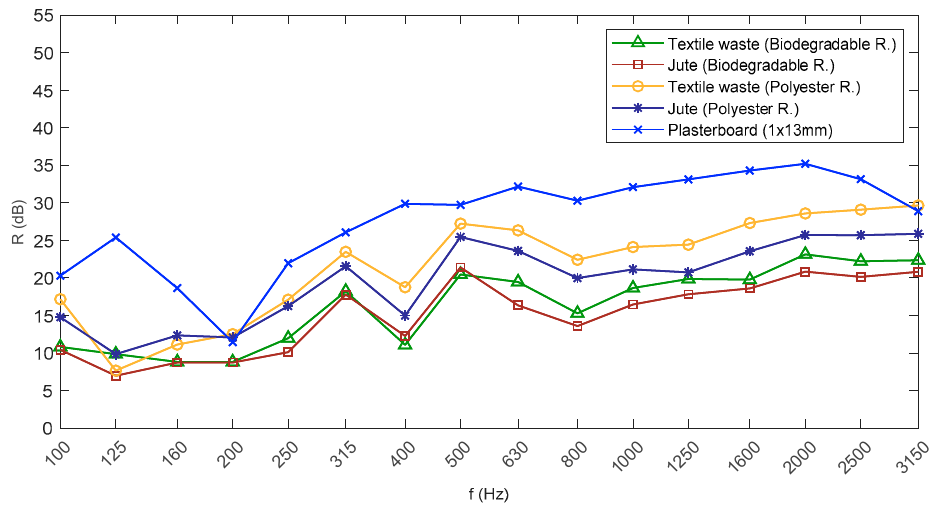
Figure 6. Sound reduction index (R (dB)) measured in reduced sized transmission chamber for green composite and plaster boards.